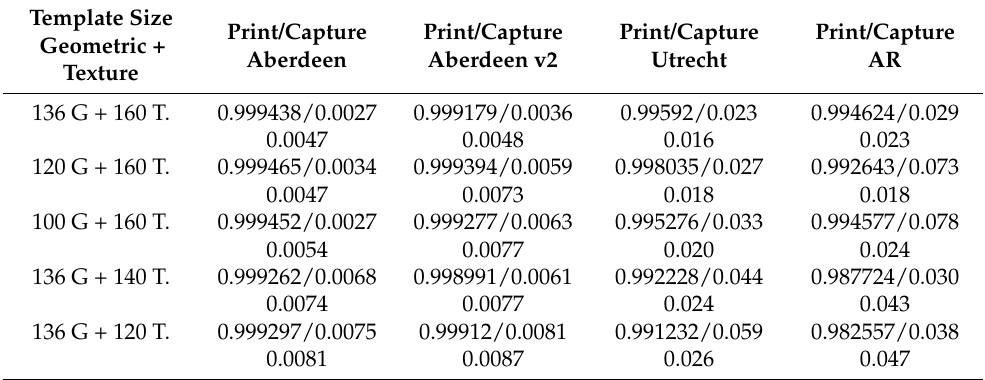
Figure 10. FAR/FRR of ANN classifier for various compression of texture features (PCA components): ( a ) Print/Capture Aberdeen; ( b ) Print/Capture Aberdeen v2; ( c ) Print/Capture Utrecht; and ( d ) Print/Capture AR. Table 1. Performance characteristics (AUC/FNMR@FMR = 0.01/Equal Error Rate(EER)) of classifiers for various sizes of compressed templates and